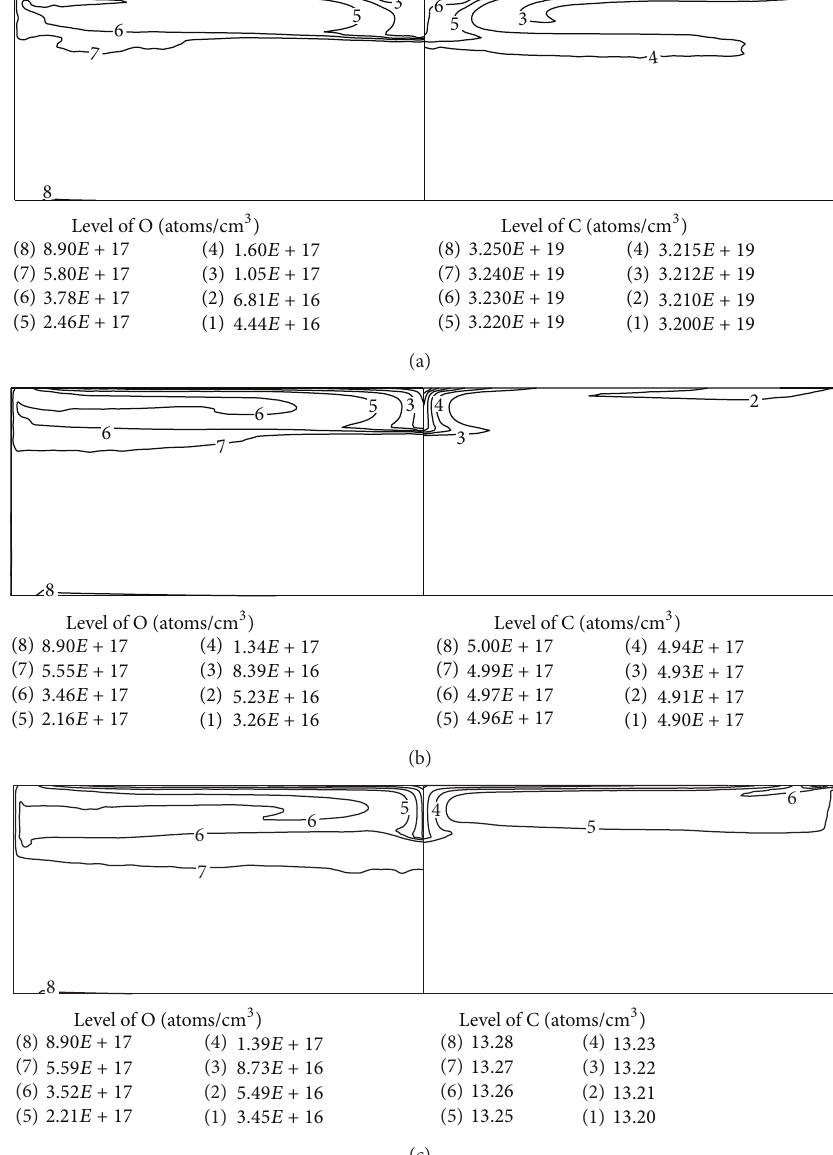
Figure 5: Distributions of O (left) and C (right) concentration in the silicon melt for different cover designs without surface reaction: (a) no cover, (b) flat cover, and (c) U